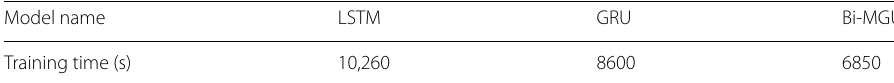
Table 1 Comparison on training time of different